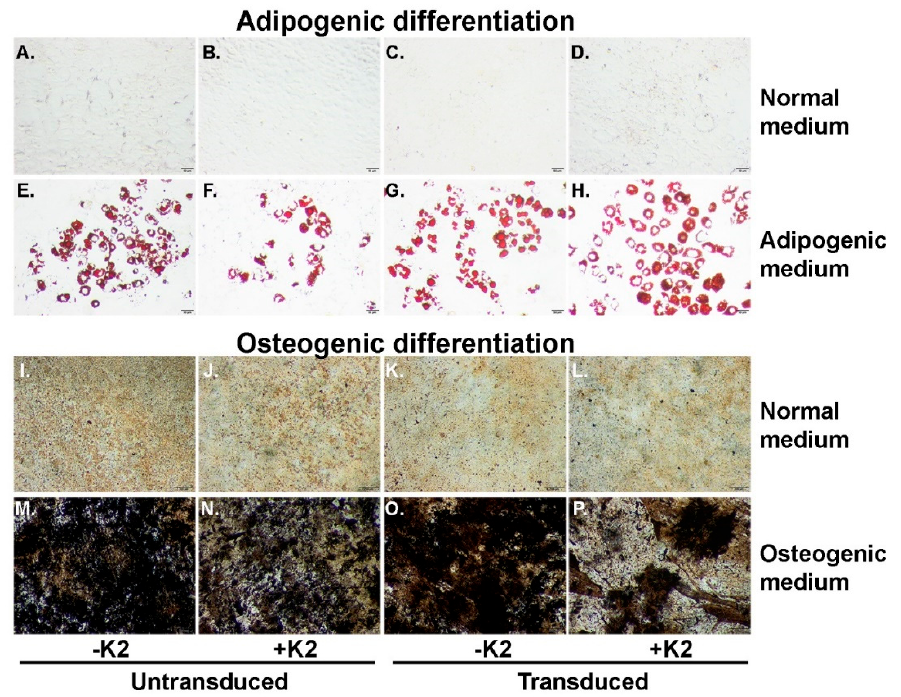
Figure 7. Exposure to K2TS does not influence the multipotency of MSC. Unmanipulated cells ( A , E , I , M ), K2TS-treated, untransduced ( B , F , J , N ), AdV-transduced ( C , G , K , O ), and AdV-transduced in the presence of K2TS ( D , H , L , P ) were cultured in normal MSC medium ( A – D ) and ( I – L ), or in adipogenic medium ( E – H ) or in osteogenic medium ( M – P ) for two weeks. The cells treated as described above were stained with Oil Red O ( A – H ), or with von Kossa protocol ( I – P ). Bars are 50 μ m ( A – H ) and 200 μ m ( I – P ).